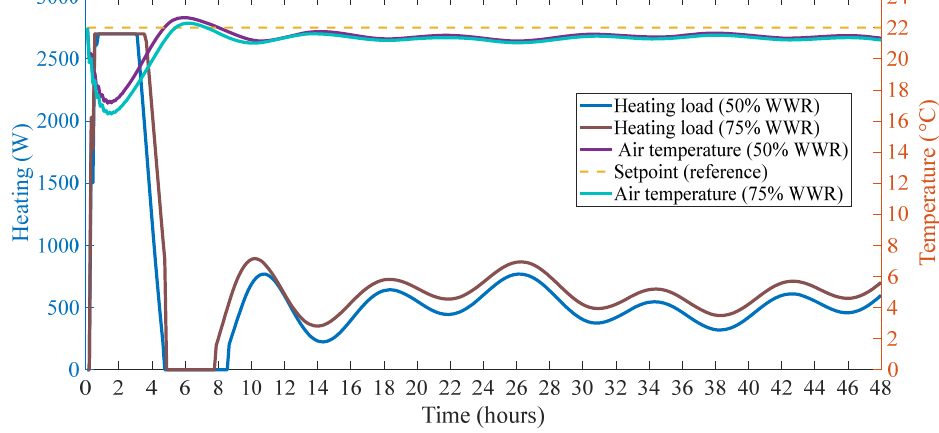
Figure 17. Comparison of air temperature control reference case for two WWRs. As expected, there is a noticeable increase in the heating load. Considering the flexible setpoint, the heating load for the 75% WWR is shown in Figure 18.